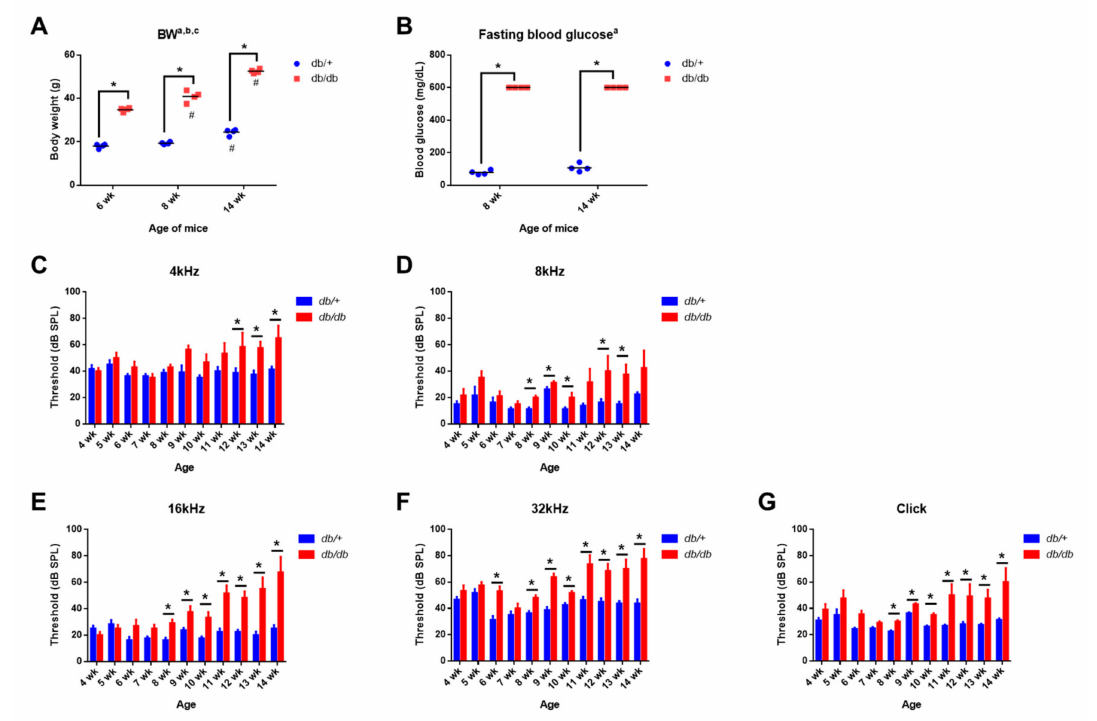
Figure 1. Diabetic (db/db) mice show hyperglycemia and impaired hearing. ( A , B ) Increased body weight and hyper- glycemia developed in male B6.BKS(D)- Lepr db /J mice. Significant differences were found in body weight ( A ) and blood glucose levels ( B ) between db/db and db/+ mice at all time points. Maximum reading from the glucometer was recorded as 600 mg/dL. n = 4 per group. All graphs represent mean ± S.E.M. Asterisk (*) denotes p < 0.05 and pound symbols (#) denote differences from matching 6 wk values; a, main effect of diabetes, p < 0.0001; b, main effect of time, p < 0.0001; c, interaction, p < 0.0001, two-way ANOVA, Tukey’s multiple comparisons test. ( C – G ) Diabetic (db/db) mice displayed a decreased hearing sensitivity compared to wild type animals. Auditory brainstem response (ABR) thresholds from db/+ and db/db mice were recorded every week between 4- and 14-weeks of age at 4 ( C ), 8 ( D ), 16 ( E ), and 32 ( F ) kHz and click ( G ) sound. ABR thresholds were significantly increased in the db/db animals compared to the db/+ mice. n = 6–10. All graphs represent mean ± S.E.M. * p < 0.05. Unpaired t